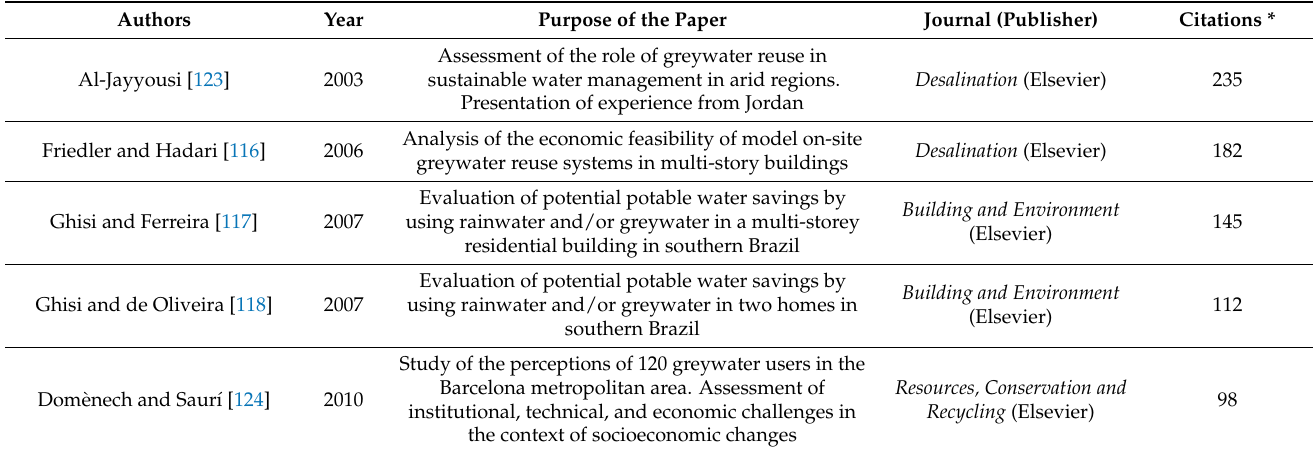
Table 8. The most cited research papers on greywater